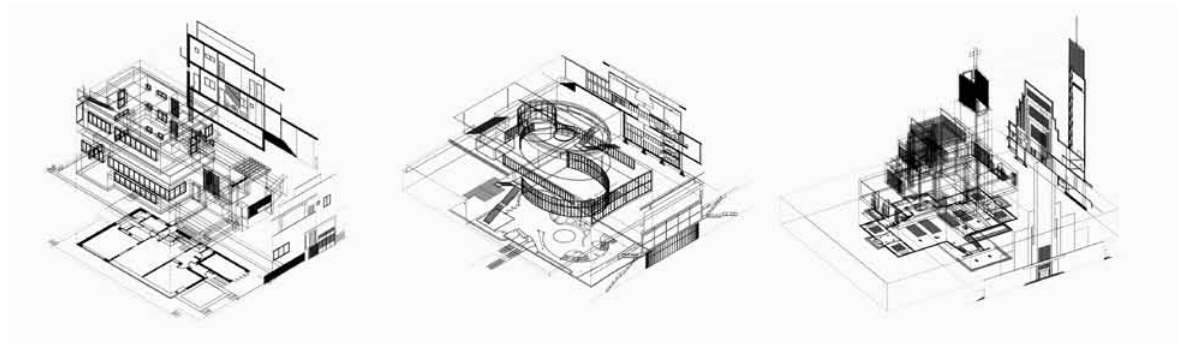
fig. 1. j. Gočár, Villa Glücklich in the Baba district, 1933 – Czech Pavilion at the Paris International Exhibition 1936 – Church and Monument to Tomáš Baťa at Zlín, 1940, re-drawing of ground floor and upper floor plans, cross section, longitudinal section, elevations and 3D